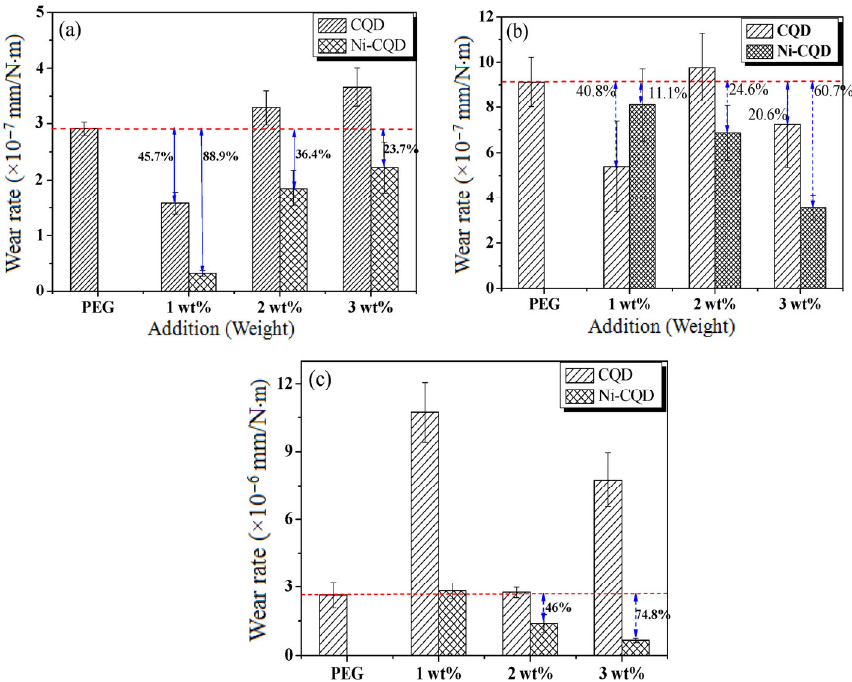
Fig. 7 Variations of wear rates of disks at 25 mm/s for 60 min under the different loads: (a) 8 N; (b) 20 N; and (c) 100 N.